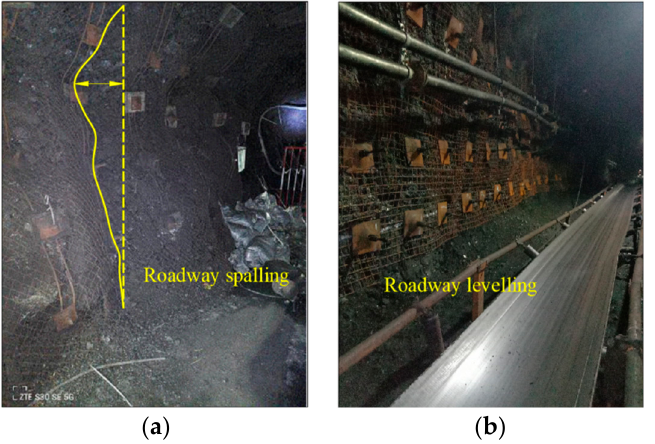
Figure 14. Deformation of the surrounding rock of the roadway before and after the optimization of the support parameters.